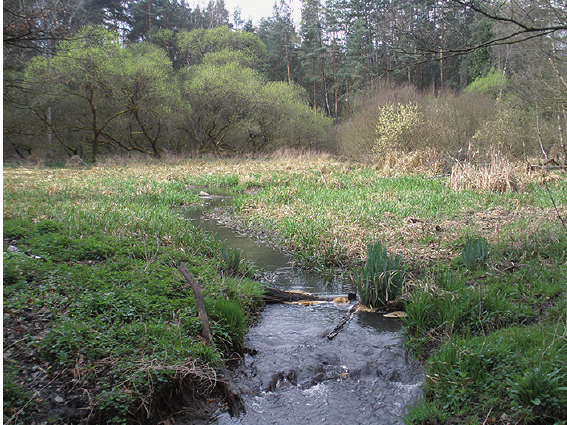
Fig. 4. Ecotope 4 – succession of vegetation of the uncovered bottom of the former pond with the Luční Brook in 2014. Photo Jan Kopp.